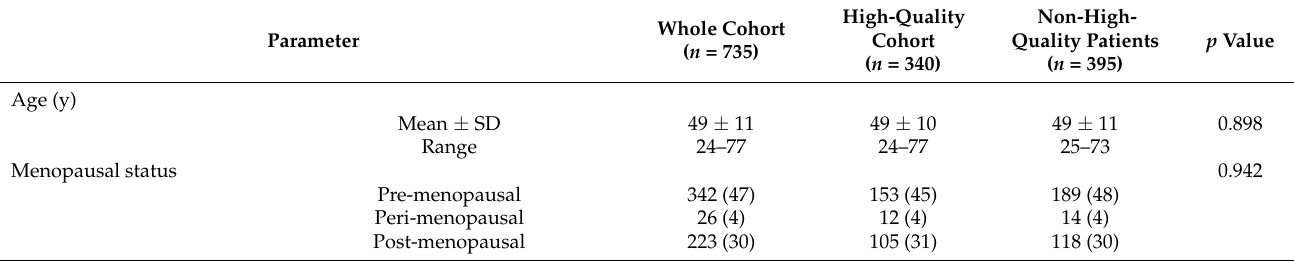
Table 2. Patient